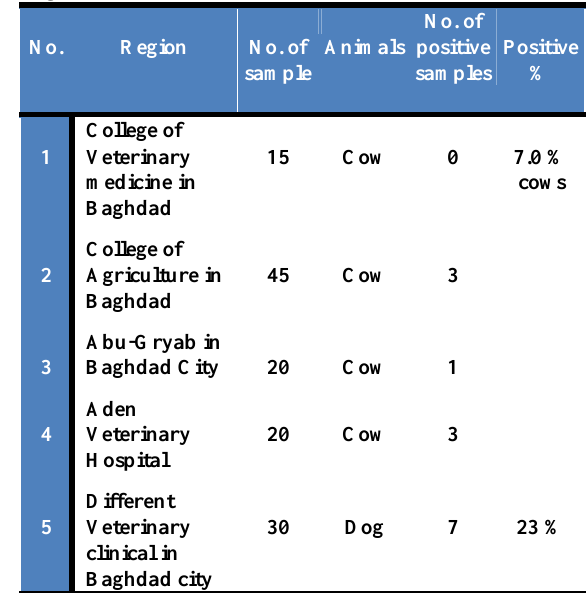
Table, 1: Source of fecal samples from cows and